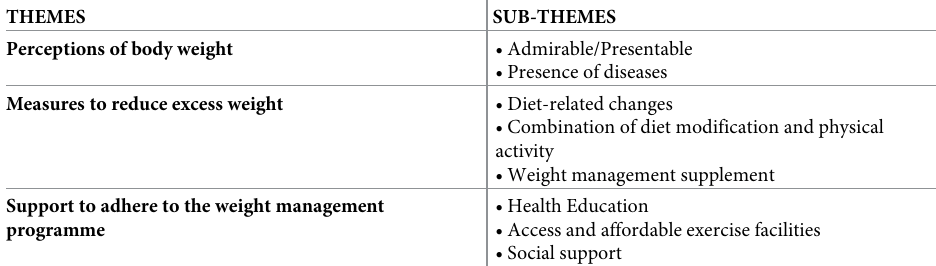
Table 2. Themes and sub-themes